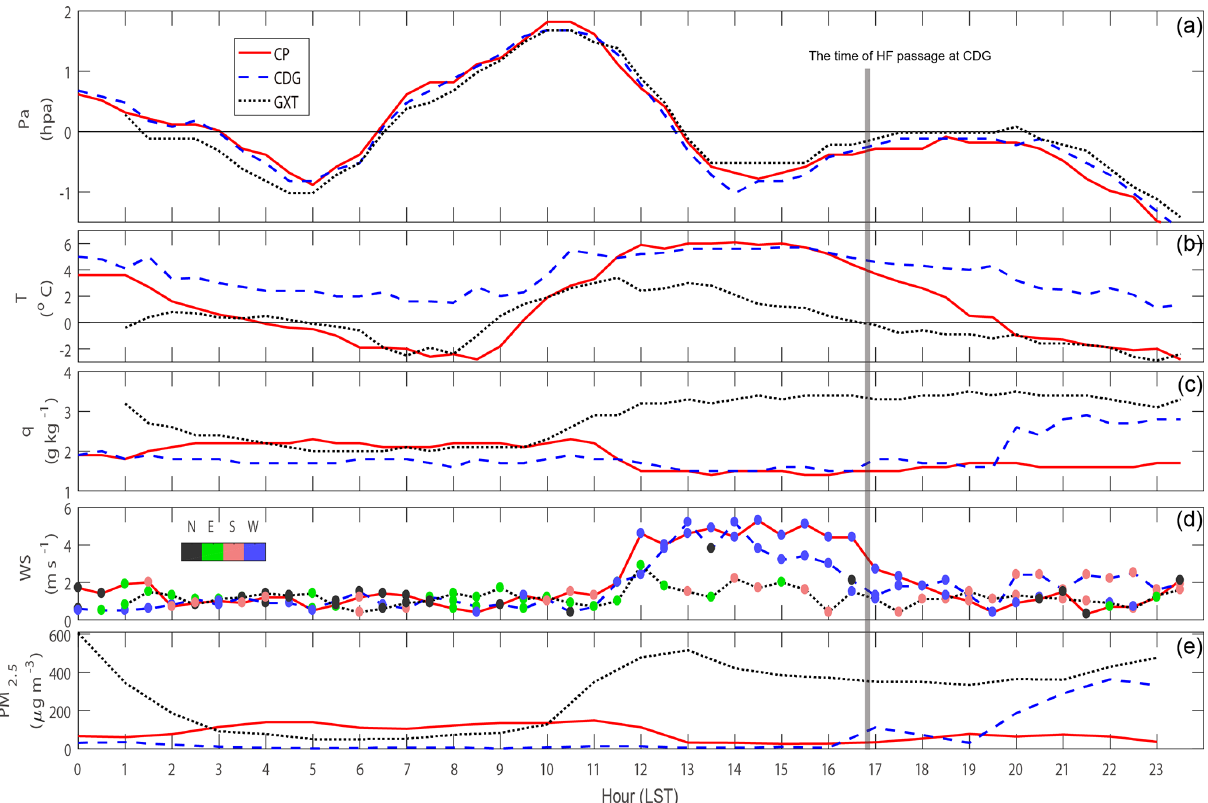
Figure 8. Half-hourly (a) pressure anomaly, (b) air temperature, (c) specific humidity, and (d) wind speed (lines) and wind directions (colored dots), and (e) hourly PM 2 . 5 concentration at CP (red line), CDG (blue dash line) and GXT (black dash line) on 24 December 2015. The gray line indicates the time of HF passage at